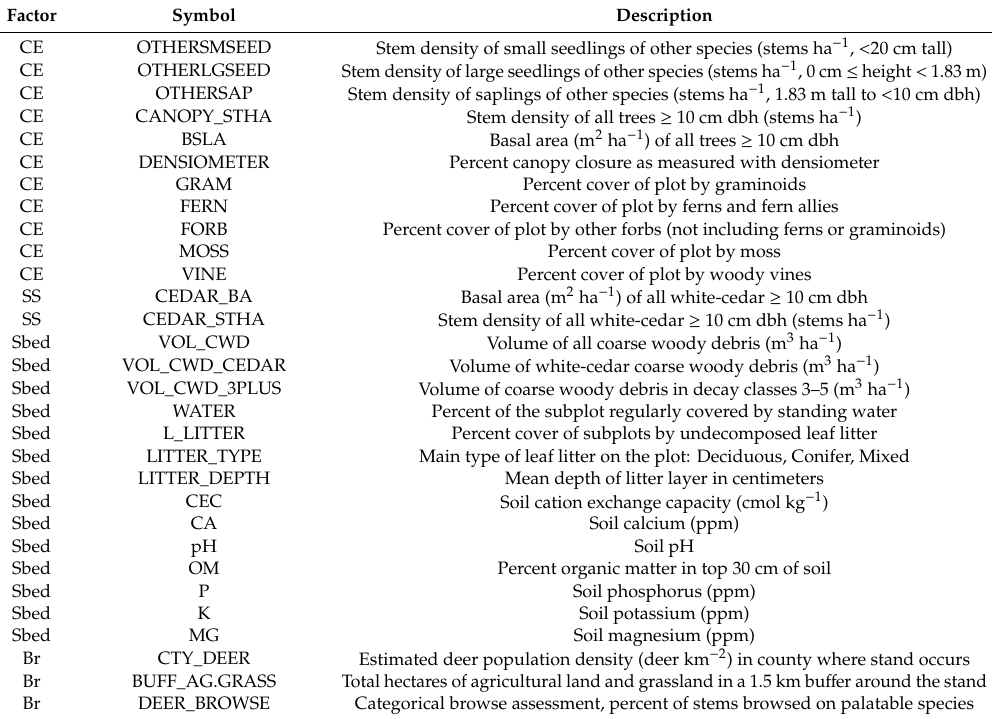
Table 2. List of potential predictor variables for stem density of white-cedar regeneration. Factors